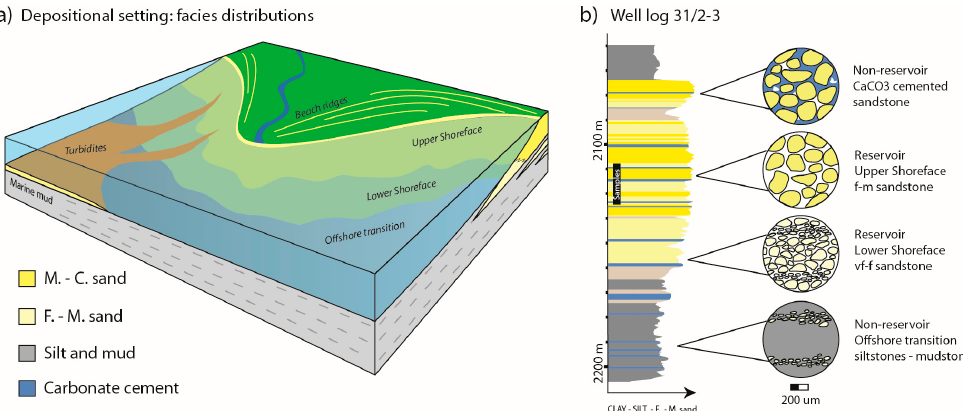
Figure 2. ( a ) Simplified sedimentary facies distributions for the Johansen Formation. Mineralization potential for the reservoir intervals are given for upper and lower shoreface sandstones; ( b ) an interpreted lithological log (vertical section through the sandy Johansen Formation with the muddy over- and underlying Amundsen Formation) from well 31 / 2-3: based on wire line log data (available at npd.factpages.no), cuttings, and a short cored section (2116–2134 m) from which rock samples were collected. The succession consists of prograding and aggrading parasequences of upper and lower shoreface deposits, with mudstones representing flooding events. Carbonate cemented sandstone layers may form within or on the top of beds due to dissolution and re-precipitation of calcareous material (e.g., shells). These layers are close to impermeable, and provide barriers to fluid flow in otherwise permeable reservoir sandstone. Generally, micro-scale observations from the di ff erent facies settings show that total grain surface area in contact with pore water (white void) increases with decreasing grain size.